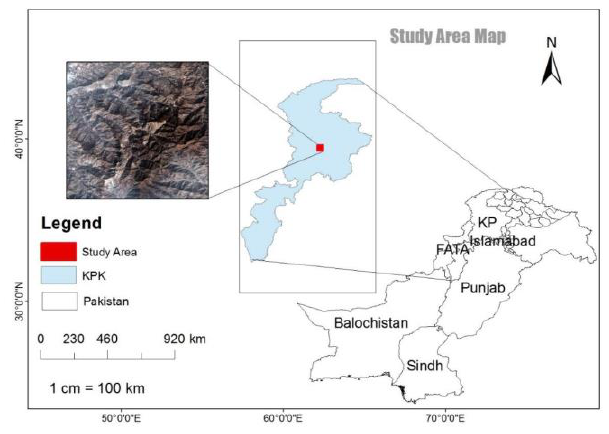
Figure 1: Study Area Map